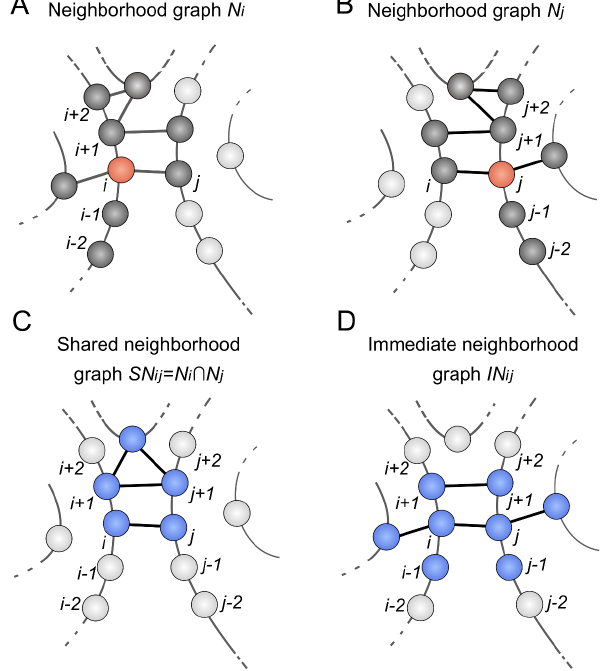
Figure 2. Definition of graphs used to model the neighborhood of the contacting residues i and j : Nodes represent residues (circles), edges represent contacts (solid black lines). A: The neighborhood graph N i for residue i contains all residues in contact with residues i { 2, i { 1, i , i z 1, and i z 2 (dark grey). B: The neighbor- hood graph N j . C: The shared neighborhood graph SN ij for the contact between residues i and j is defined by the intersection of N i and N j . Residues that belong to SN ij are shown in blue. Shared neighborhood graphs capture the local context of the shared neighborhood of the contacting residues. D: The immediate neighborhood graph IN ij is defined by all residues that are in contact to i or j . Residues that belong to IN ij are shown in blue. Immediate neighborhood graphs capture the direct neighborhood of the contacting residues.